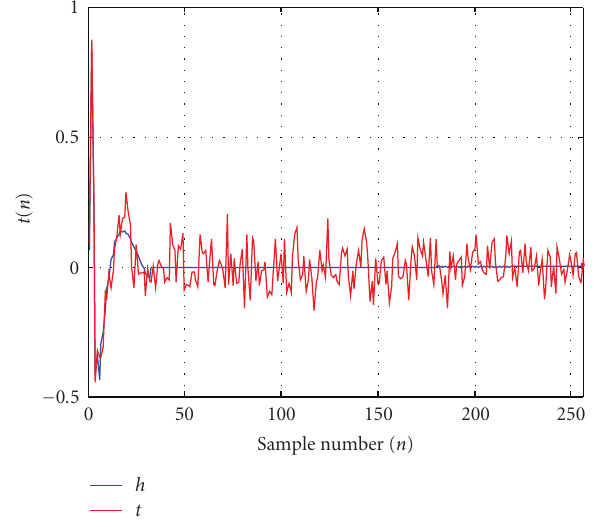
Figure 3: An example target vector.